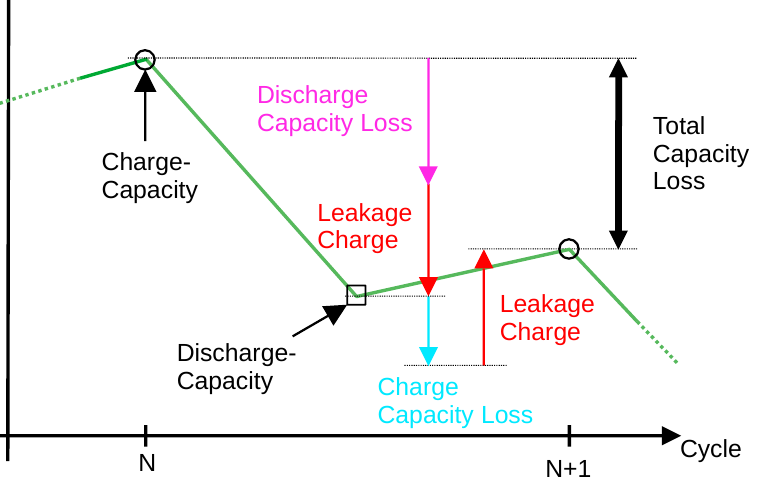
Figure 10. Breakdown of capacity degradation into its individual components: discharge capacity loss, charge capacity loss and leakage